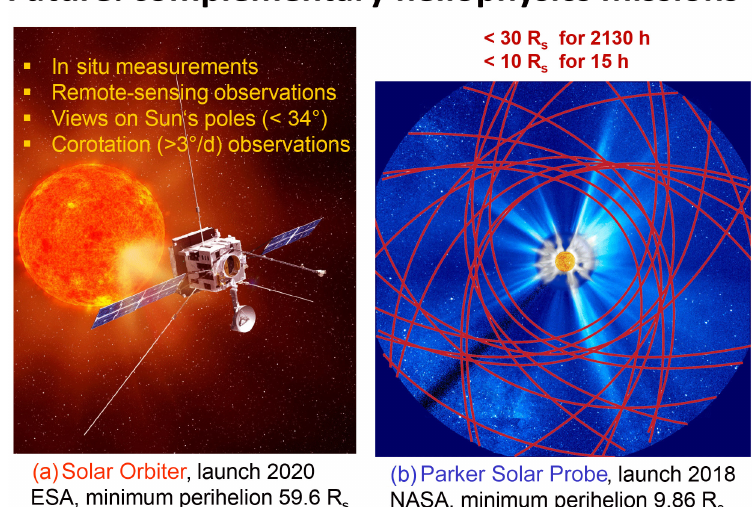
Figure 15. Illustration of the future complementary heliophysics missions, Solar Orbiter of ESA (a) and Parker Solar Probe of NASA (b) . Some key parameters of the missions are given together with characteristics of their